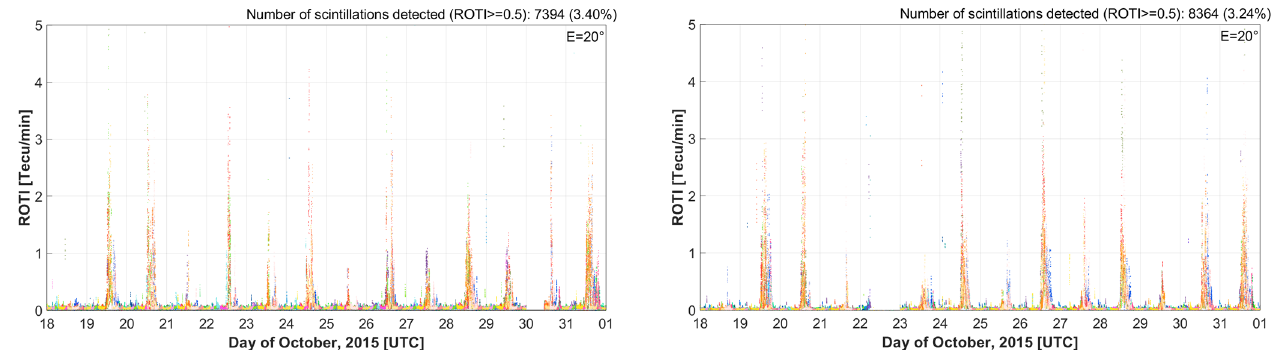
Figure 8. ROTI observations during the period of 18–31 October 2015 at Hue ( left ) and CUSV ( right ) stations. It can be seen that ionospheric disturbances occurred densely during this period. These was also one of the periods when the Sun was most active during the last solar cycle and almost all GNSS stations in the Southeast Asia region were strongly affected.